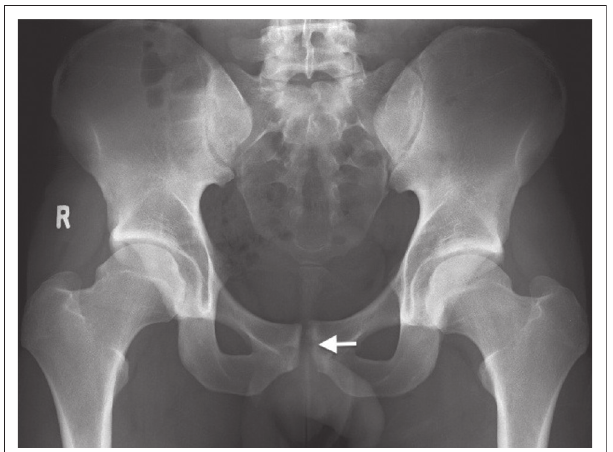
FIGURE 4: Osteitis pubis. Pelvic radiograph in a 21-year-old soccer player presenting with left groin pain demonstrating symphyseal cortical enthesiopathic changes on the left (white arrow). See Figure 6 for correlative MRI. There is also incidental cam-type femoro-acetabular impingement